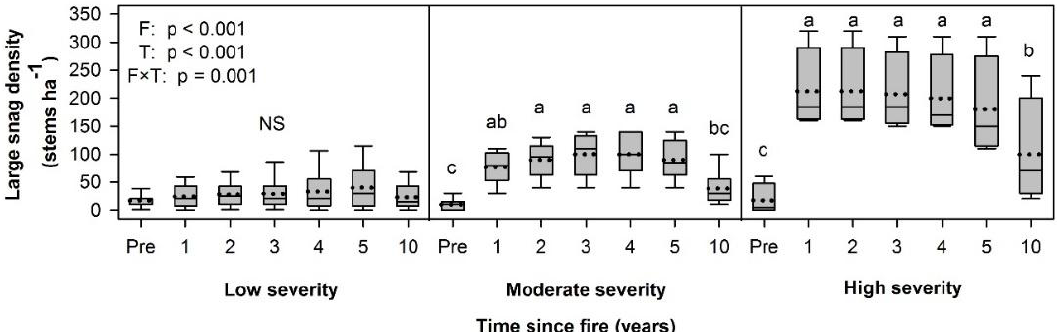
Figure 5. Large (>20 cm DBH) snag density with respect to fire severity and time since fire. Boxes represent 25th, 50th, and 75th percentiles, whiskers represent 10th and 90th percentiles, and dotted lines represent means. The p -values are model results for the effects of fire severity (F), time since fire (T), and their interaction (F×T). Letters separate means though time within severity classes; NS indicates that means did not differ.